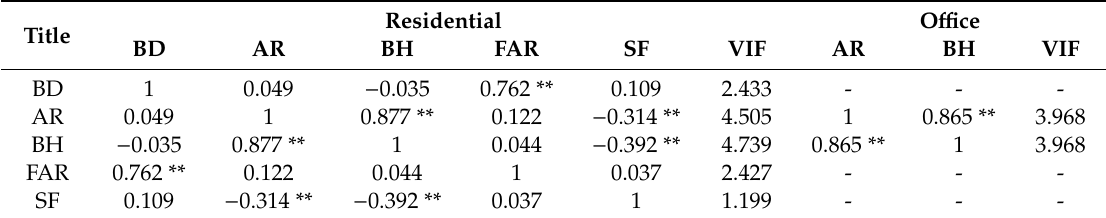
Pearson correlations between urban morphological parameters of residential and o ffi ce buildings.